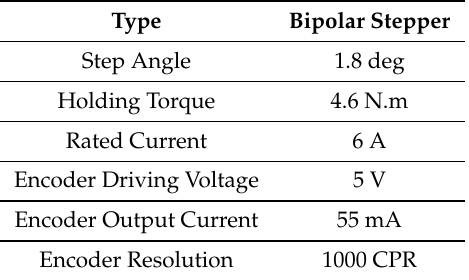
Table 1. Technical specifications of the robot